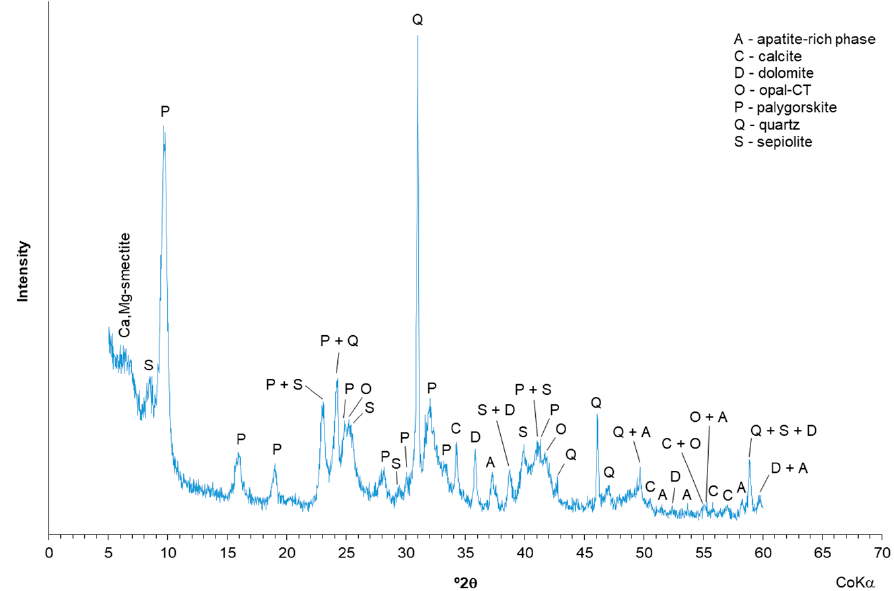
Figure 1. XRD of the palygorskite with identification of the mineral phases.